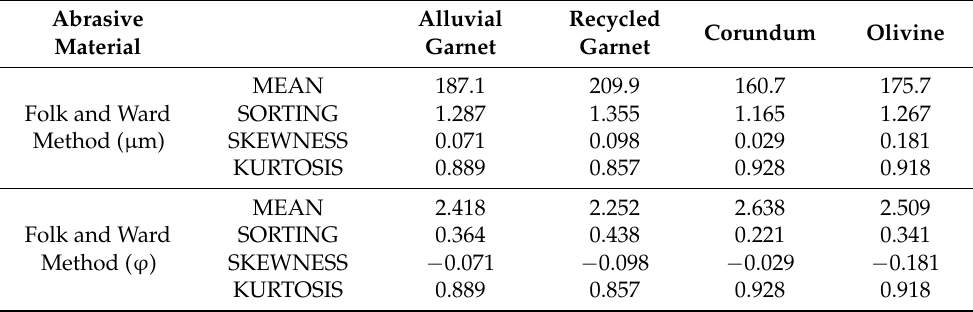
Table 8. Recycled abrasives grains distribution statistics.